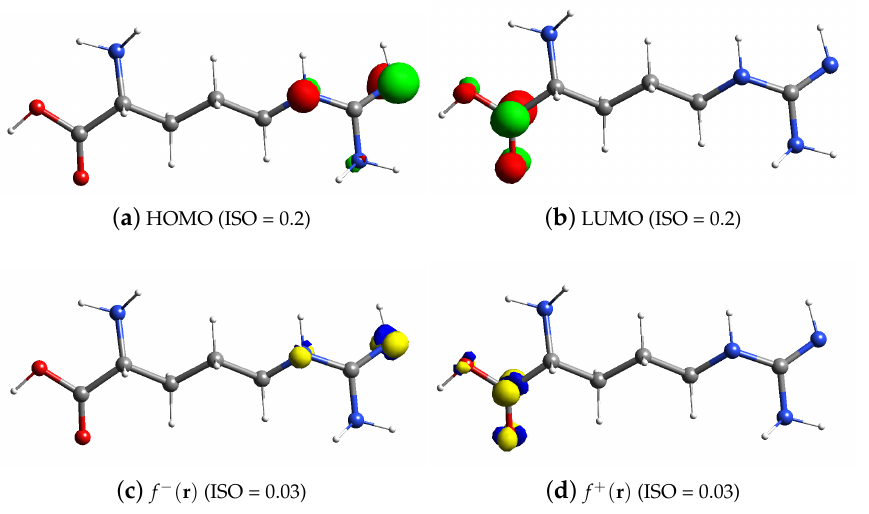
Figure 3. FMO and analytical Fukui analysis of